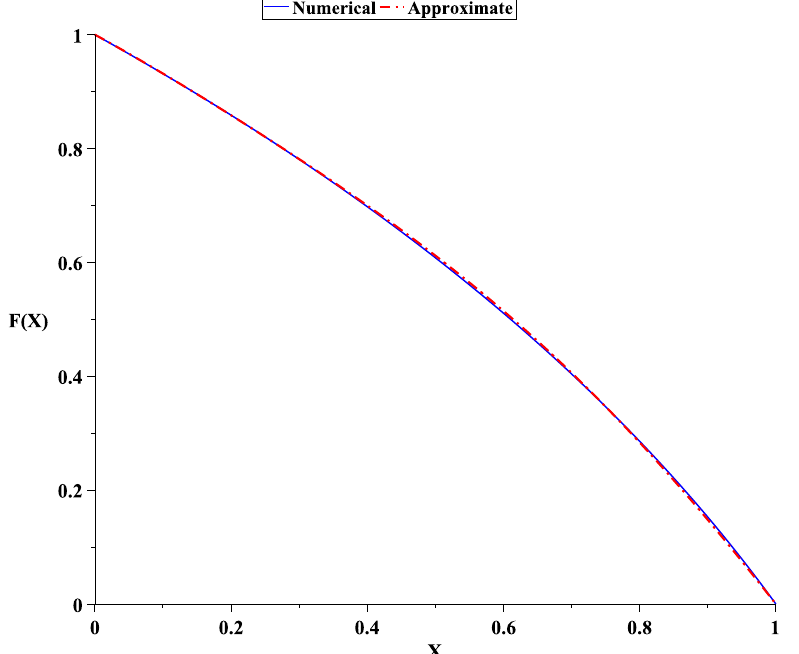
Figure 2. Equation (59) for ε = 0.5 (solid blue line) vs. approximate solution (74) (dash-dot red